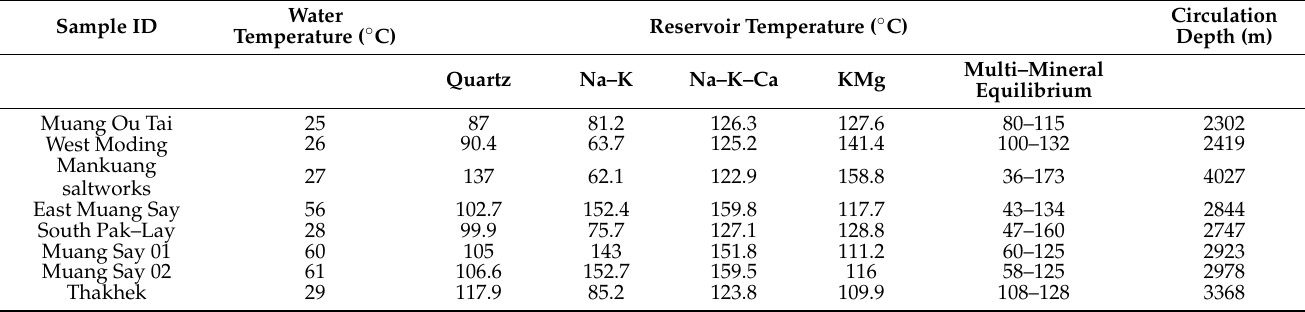
Table 3. Estimated reservoir temperatures of saline spring water samples from north and central Laos. Sample